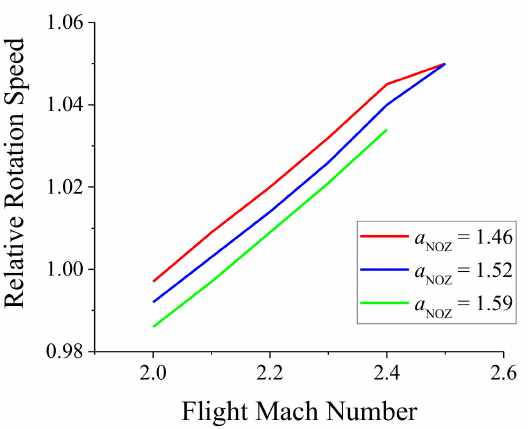
Figure 23. The Variations of Relative Rotation Speed of High-Pressure Shaft at the conditions of Different Throat Area Coefficients of Main Nozzle ( α NOZ ).